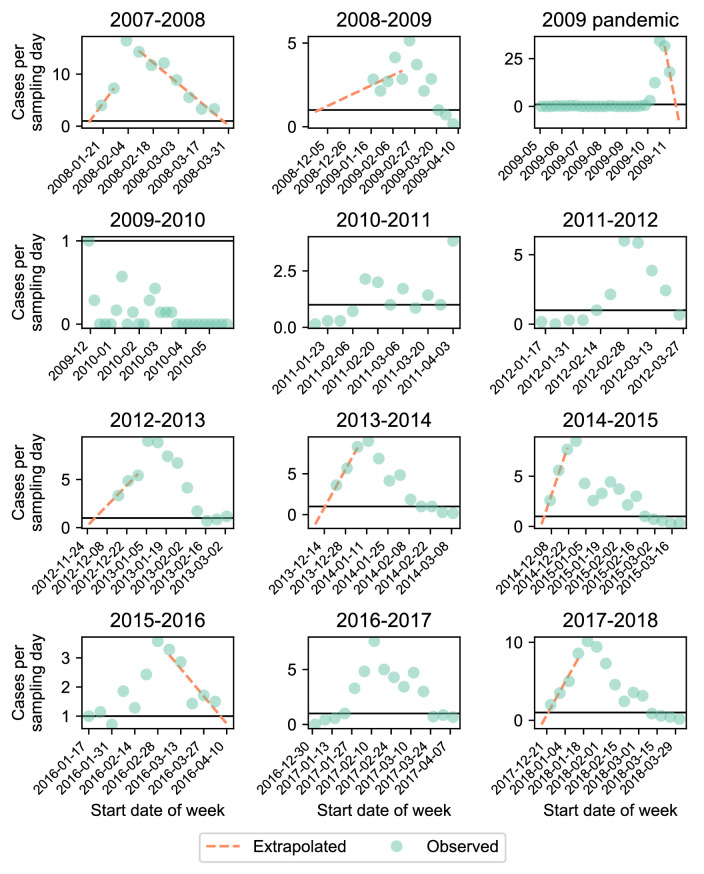
Cases per sampling day.Each panel shows the number of cases per sampling day (green circles). We extrapolated cases at the start and end of the season (orange dashed line) if the observed number of cases per day exceeded 1 (black line) at the start and end of that season (Appendix 1: ‘Sensitivity to sampling effort’).